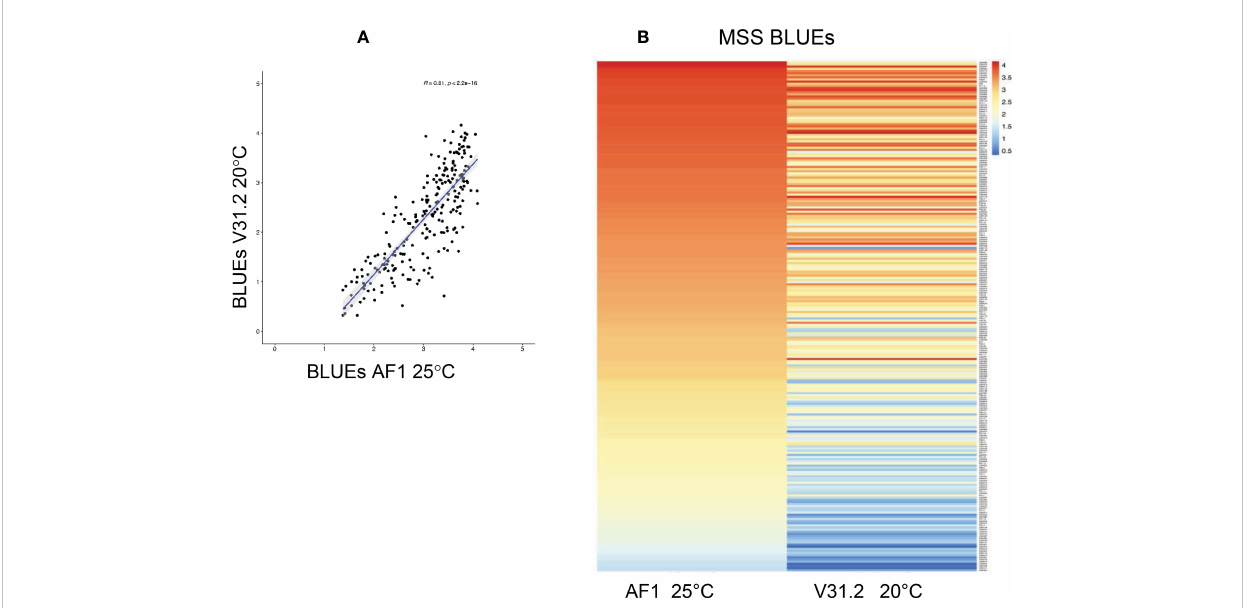
FIGURE 3 Comparison of the Maximum Symptom Score (MSS) response of a panel of 242 M. truncatula accessions inoculated with Verticillium alfalfae strain AF-1 at 25 °C and strain V31.2 at 20 °C. (A) Pearson correlation coef fi cient. (B) Heatmap of MSS